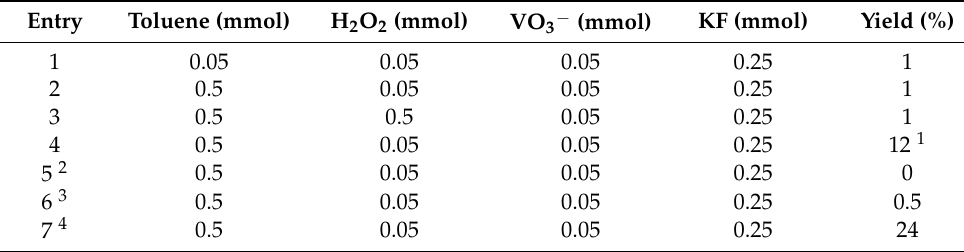
Table 2. Toluene oxidation in H 2 O, pH = 1, T = 25 ◦ C, 24 h.